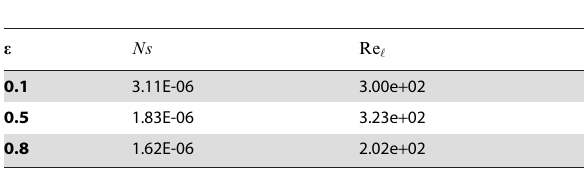
Table 3. Updating p in RPF with e ~ 0 : 5 . Table 4. RPF with different values of e .